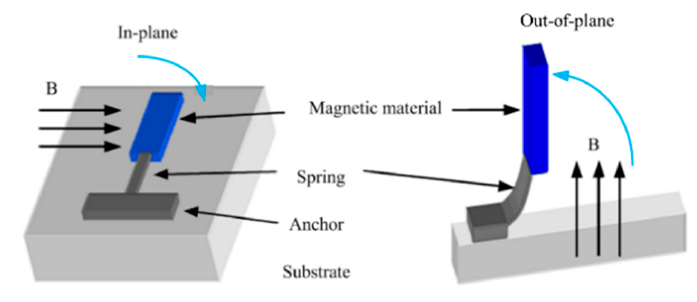
Figure 22. Electromagnetic actuators with magnetic materials formed on the movable structure.